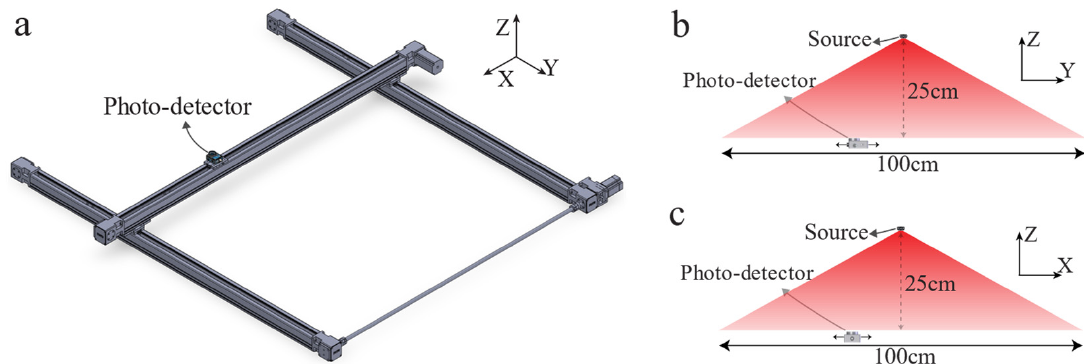
Figure 4. The experimental setup computer-aided design (CAD). ( a ) Dimetric view of the photode- tector and the 2D translation stage, which measures the light intensity and its uniformity. ( b ) 2D view (yz-plane) of the setup. The source placed 25 cm above the center point of the scanner to obtain experimental results. ( c ) 2D view (xz-plane) of the setup. The source placed 25 cm above the center point of the scanner to obtain experimental results.